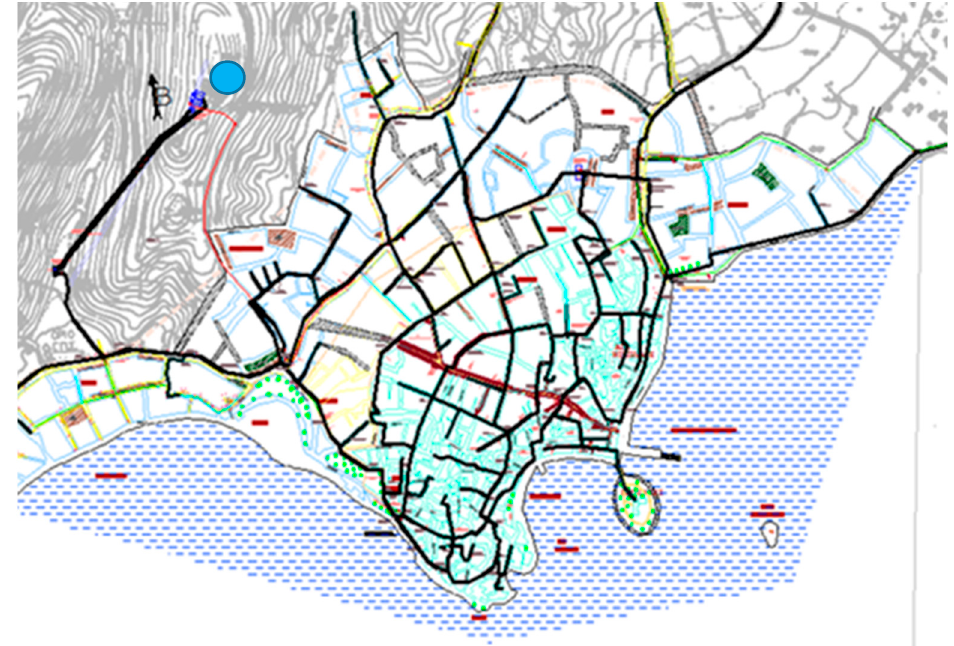
Figure 2. Skiathos W.D.N. denoted in black with its main drilling denoted in